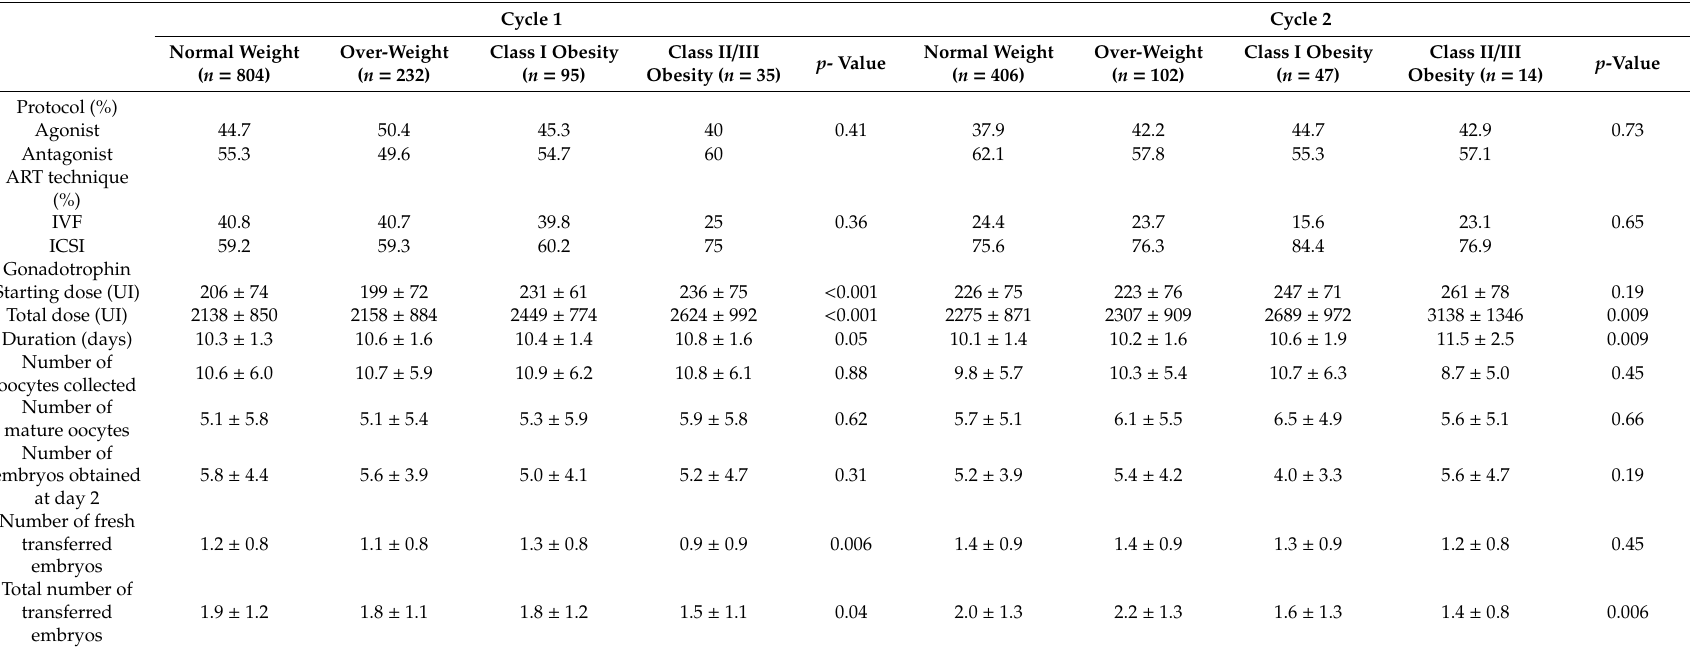
Table 2. Characteristics of Controlled Ovarian Stimulation for the Two First Cycles by BMI